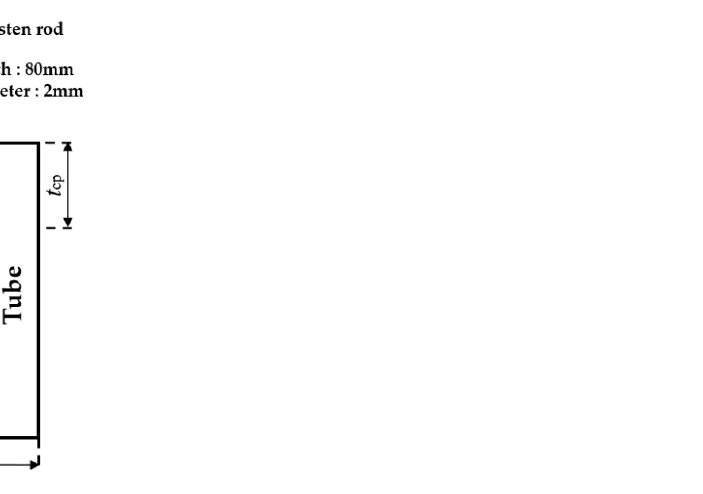
Figure 1. Structure geometry of the confined SiC target used in the experiments. In the present numerical simulations, thickness of the cover plate ( t cp ) ranges from 3 mm to 8 mm at an interval of 1 mm.